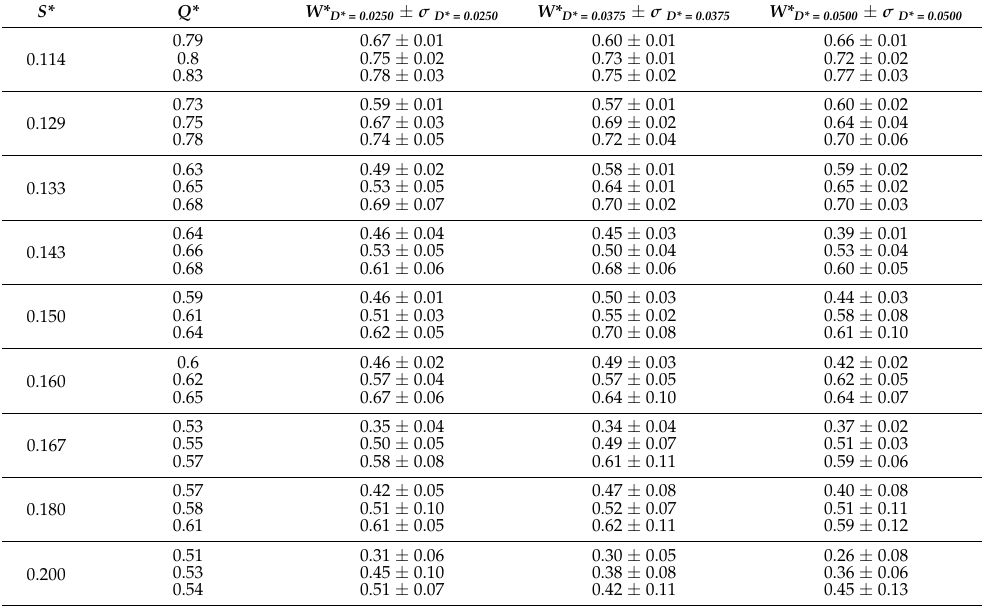
Table 1. Mean and standard deviation of the dimensionless